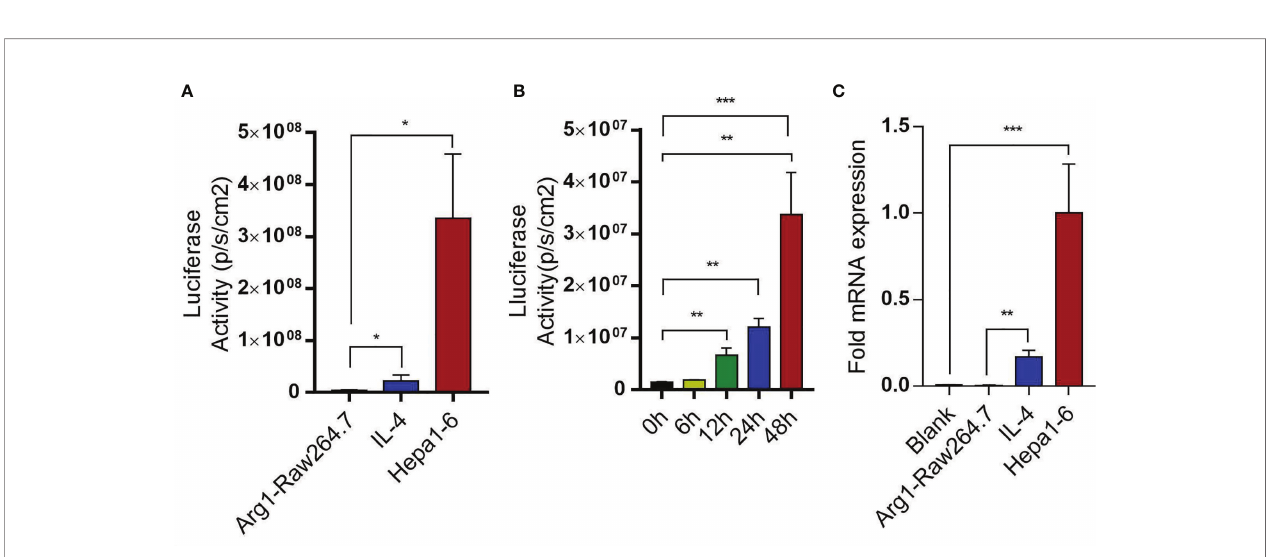
FIGURE 6 | Arg1EP-Luciferase-GFP/Raw264.7 macrophage sensors in tumor microenvironment. (A) Luciferase activity of macrophage sensors in different tumor microenvironments. (B) In the condition of co-incubation of Hepa1-6 showing increased luciferase activity of macrophage sensors within 48 h. (C) Changes in Arg1 mRNA levels after IL-4 inducein and in tumor microenvironment. Mean ± S.D; n=3, Statistical signi fi cance is determined with t test; *P<0.05,